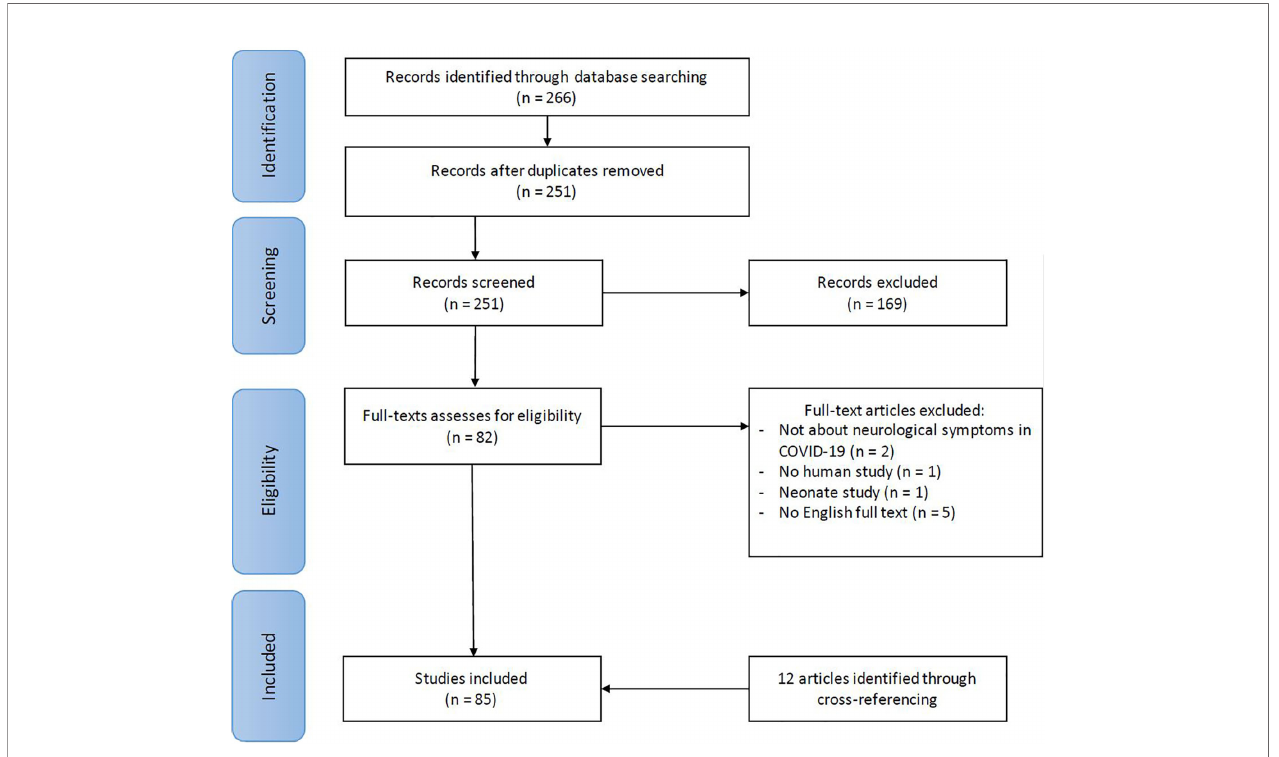
FIGURE 1 | Flowchart article selection